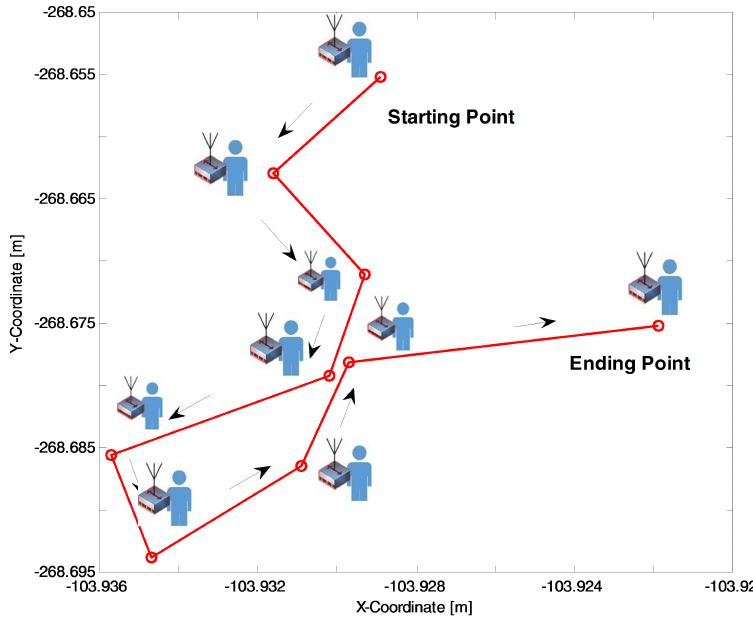
Figure 5. mPC traveling pattern in public safety deployed